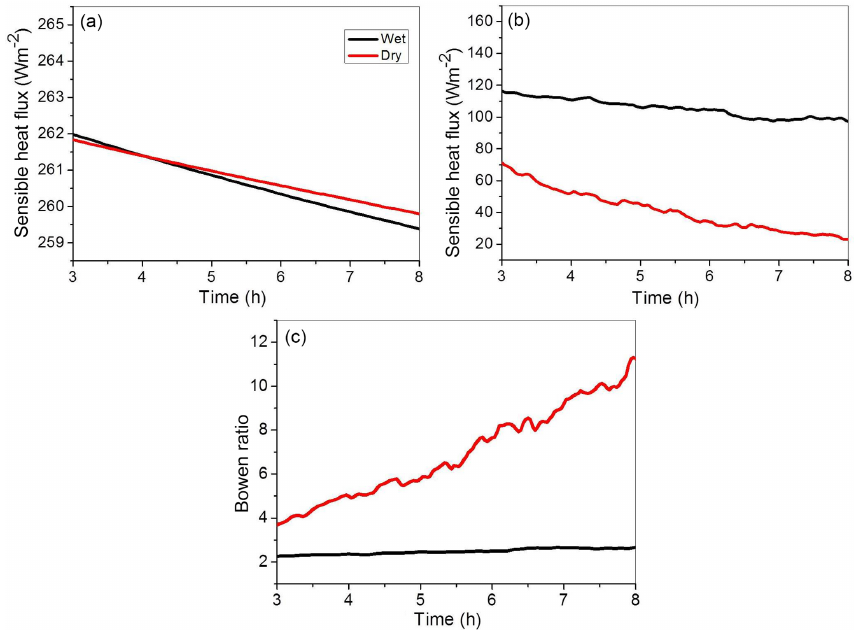
Figure 9. Evolution of (a) the sensible heat flux, (b) the latent heat flux, and (c) the Bowen ratio in simulations of dry and wet cases from the IGOC field project. Red/black lines are for the dry/wet case.